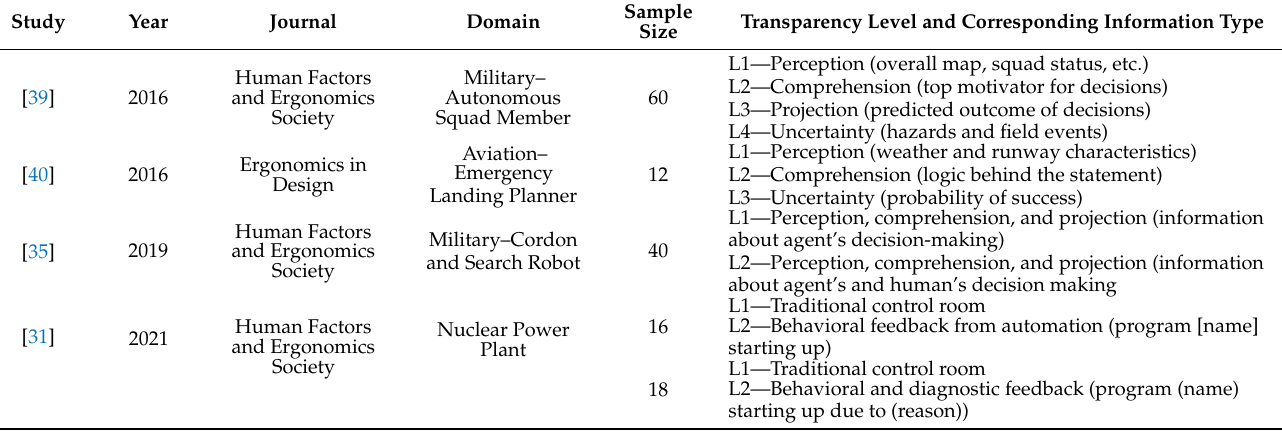
Table 3. The details of the studies included in the